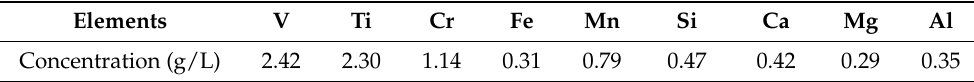
Table 1. Chemical composition of the pregnant leachate